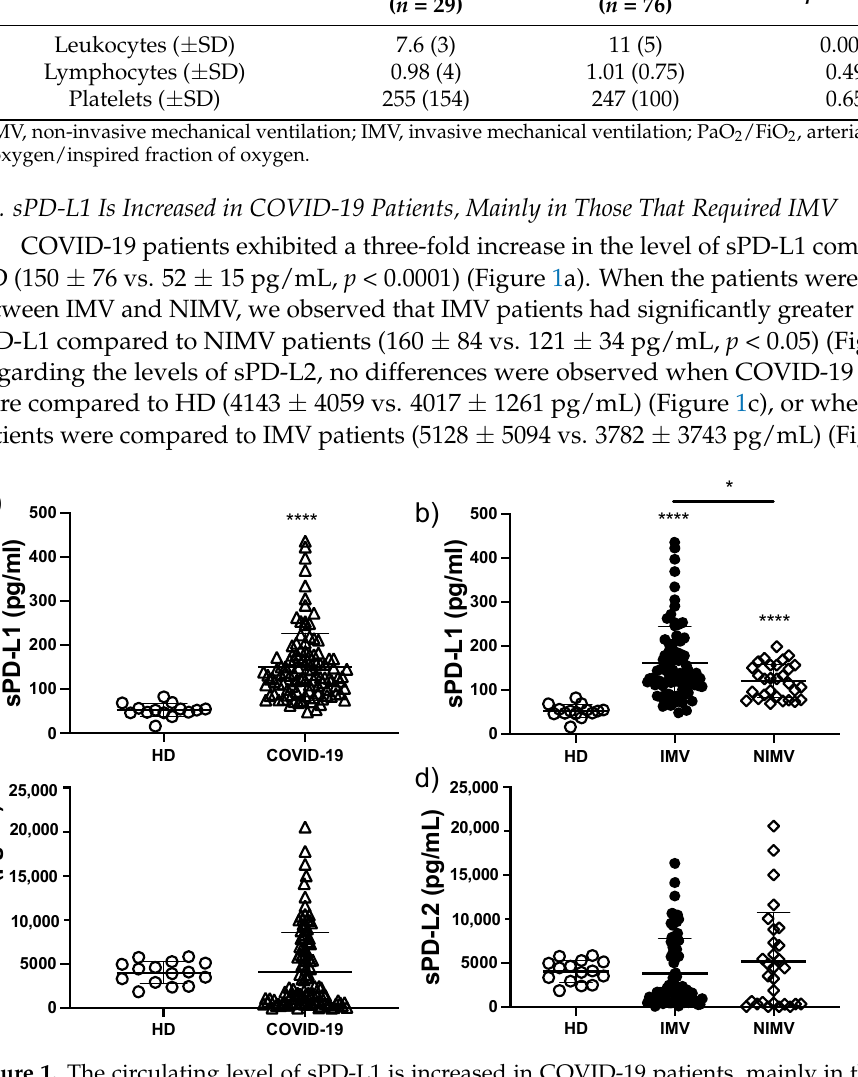
Figure 1. The circulating level of sPD-L1 is increased in COVID-19 patients, mainly in those that required IMV. Serum levels of sPD-L1 were evaluated in total COVID-19 patients and divided into invasive mechanic ventilation (IMV) and non-invasive mechanic ventilation (NIMV) groups ( a , b ). Serum levels of sPD-L2 were evaluated in total COVID-19 patients and divided into IMV and NIMV groups ( c , d ). Graphs show individual values and the mean ± SD. Statistical analysis was performed with the Mann–Whitney test ( a , c ) or an ANOVA test adjusted by the Kruskal–Wallis method ( b , d ). * p < 0.05, **** p < 0.0001. Asterisks indicate a significant comparison with the healthy donor (HD) group, and when the asterisk is over a line, it indicates a significant comparison between IMV and NIMV. Empty circles represent healthy donors group, empty triangles COVID-19 group, black circles IMV group, empty diamonds NIMV group.